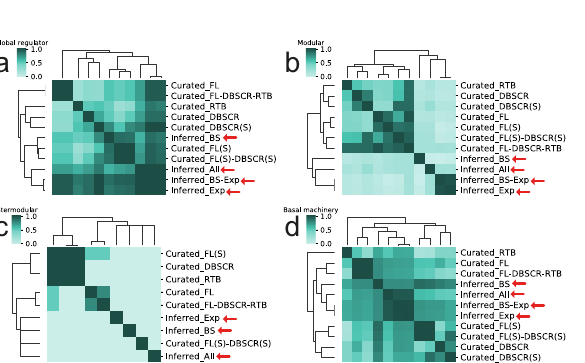
Figure 5. Simpson similarity index for NDA analysis for all curated and inferred networks. ( a ) Global regulators. ( b ) Modular genes. ( c ) Intermodular genes. ( d ) Basal machinery